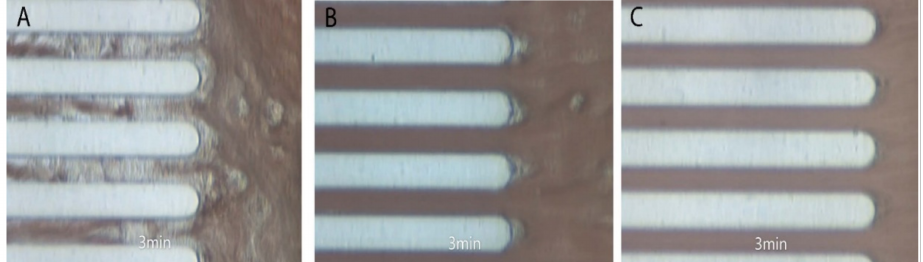
Figure 5. Examples of pictures obtained during thrombus formation in the whole blood perfusion scheme. ( A ) (i) A control patient who achieved total occlusion of the microchip after 3 min 40 s, ( B ) (ii) a patient treated with epoprostenol who achieved clotting after 9 min 39 s, and ( C ) (iii) a patient treated with treprostinil who did not achieve clotting during the measurement time of 12 min. All pictures were made at 3 min. The full movies are attached in the online Supplementary